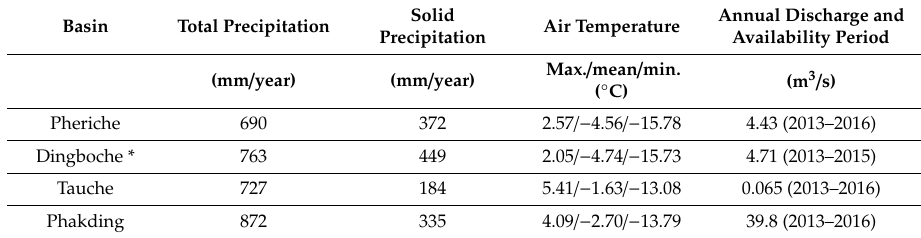
Table 2. Average total and solid precipitation, air temperature, and mean annual discharge for the river basins studied, over the period 2013–2016. Values are given for the total area of the basins, including the glacierized areas for the studied sub-basins. * Discharge data for Dingboche are not available until 2016 owing to damage at the hydrological station that occurred during the April 2015